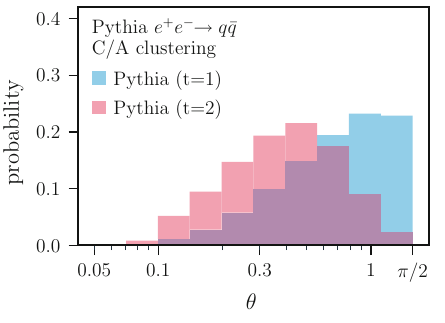
Fig. 19 (Left) Evolution of the θ distribution from t = 1 to t = 2 in thevalidationsetof Pythia jets.(Right)Correspondingevolutionofthe branching function as predicted by a “local” branching model without access to the hidden representation h ( t ) . Disagreement between Pythia